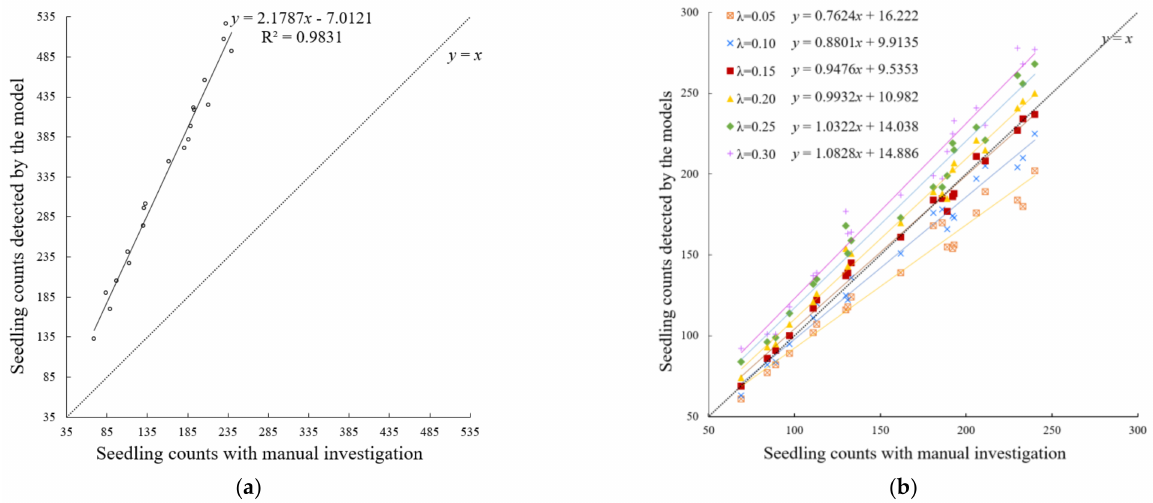
Figure 11. Correlation between the seedling counts predicted by the models and manual investigation. X axis represents the ground truth, whereas y-axis represents the count result anticipated by the matching models. ( a ) Correlation of the model without de-duplication. ( b ) Correlation of the models with